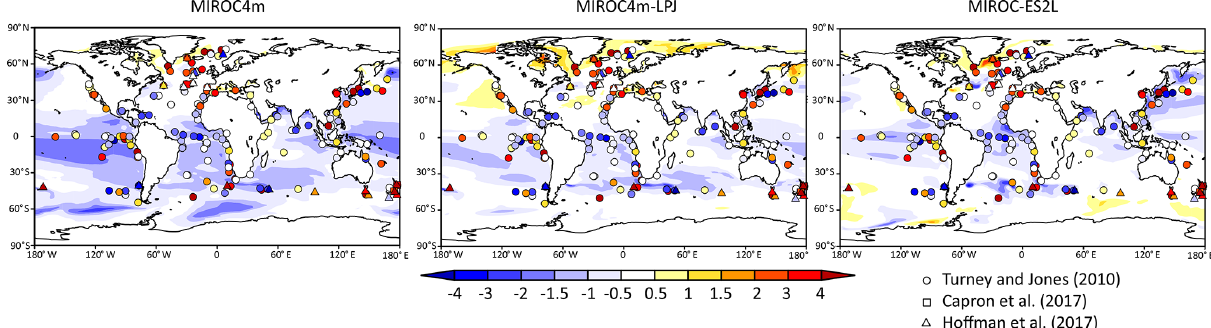
Figure 7. The annual sea surface temperature change (K) in 127k from PI is compared with reconstructions by Turney and Jones (2010), Capron et al. (2017), and Hoffman et al. (2017).